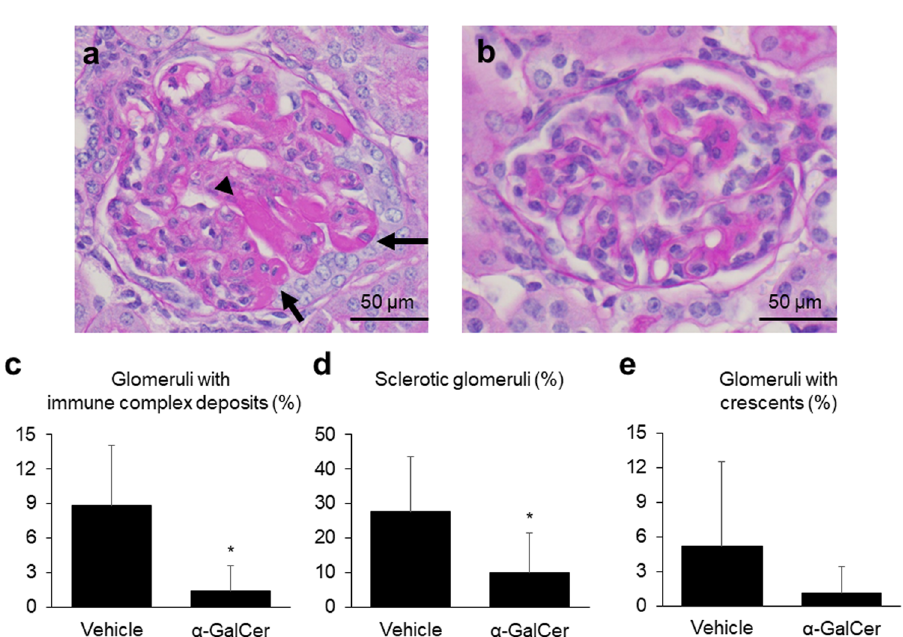
Figure 2. Kidney pathology of experimental lupus nephritis is ameliorated by treatment with alpha- galactosylceramide ( α -GalCer). Representative images of periodic acid-Schiff staining of kidney slices in the ( a ) vehicle and ( b ) α -GalCer groups. Arrows, immune complex deposits; arrowhead, segmentally sclerotic area. The percentages of ( c ) glomeruli with immune complex deposits, ( d ) sclerotic glomeruli, and ( e ) glomeruli with crescents in each group (vehicle group; n = 5, α -GalCer group; n = 7). * p < 0.05 compared with the vehicle